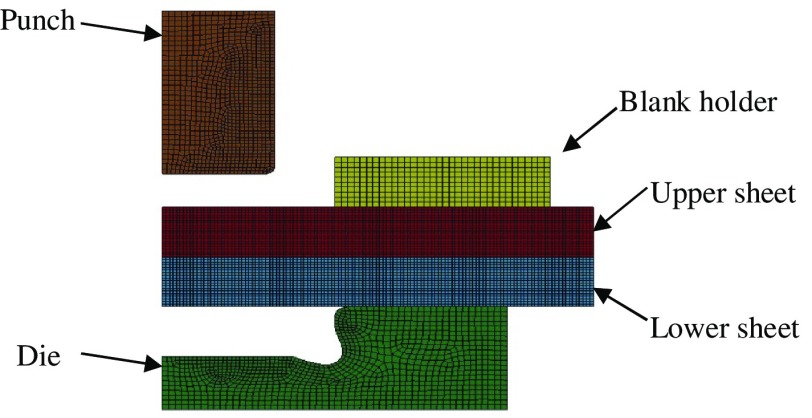
FE model of the clinching process [63].